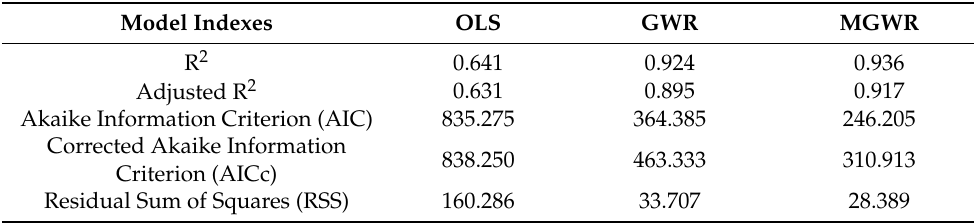
Table 2. Model index of OLS, GWR and MGWR.